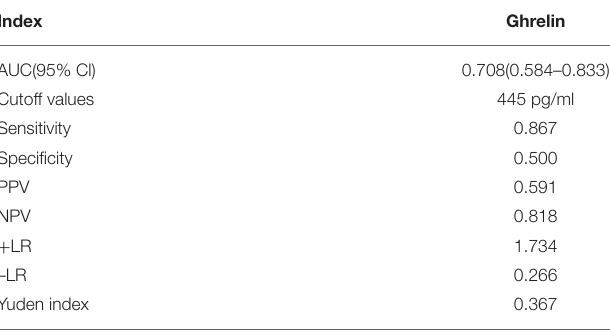
TABLE 2 | Diagnostic evaluation index of plasm ghrelin.